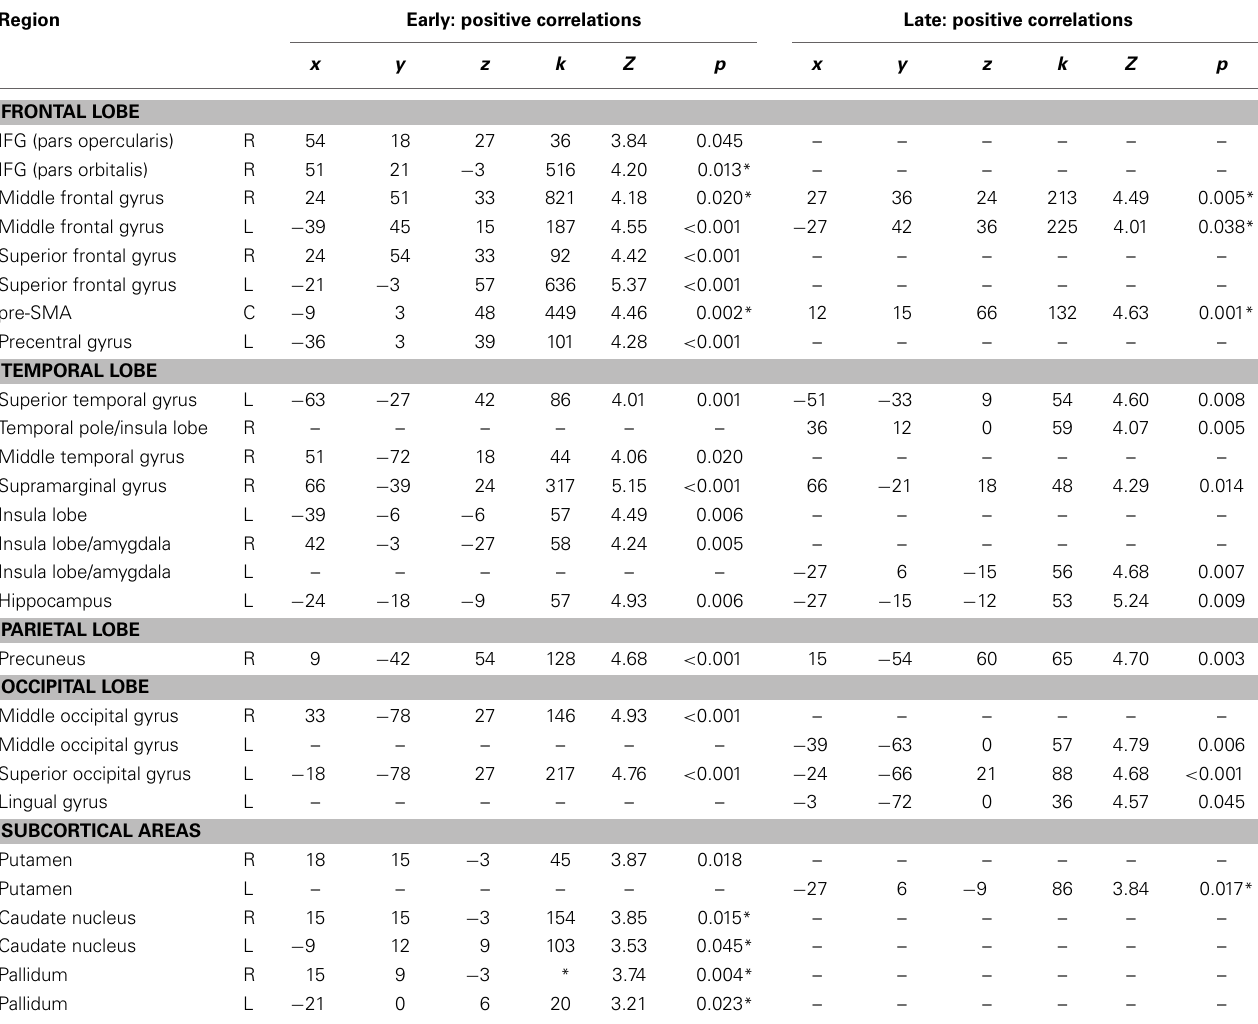
Table 1 | Positive correlations of fMRI BOLD signal with orthogonalized EEG-derived regressors early (time window starting 200ms after stimulus onset and ending with the individual median RT) and late (time window starting 100ms prior to RT and ending 300ms after RT). Region